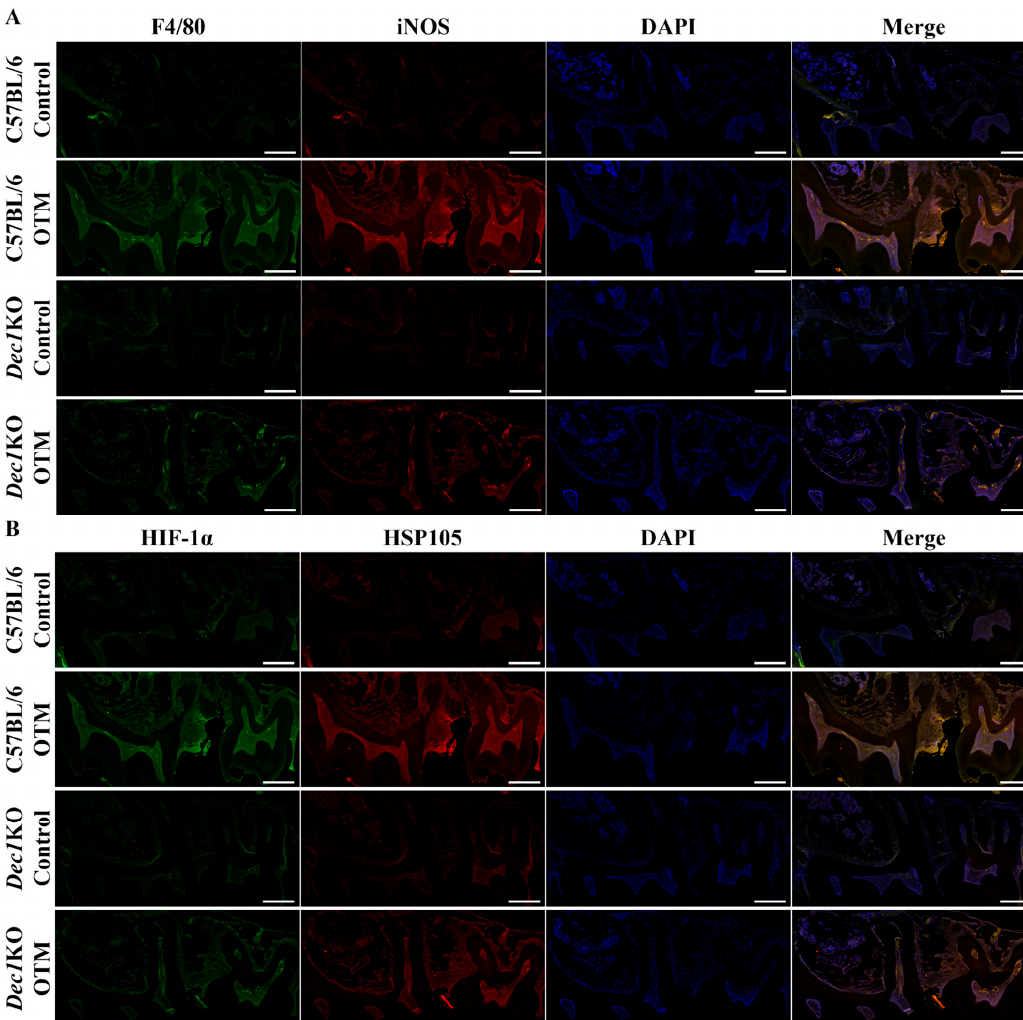
Figure 10. Effect of Dec1 on F4/80, iNOS, HIF-1 α and HSP105 in the OTM mouse model. ( A ) F4/80 and iNOS were reduced in the PDL fibroblasts of Dec1 KO OTM mice compared with WT OTM mice. ( B ) Deficiency of Dec1 decreased the expression of HIF-1 α and HSP105 in PDL fibroblasts of the OTM mouse model. All specimens were incubated with Zenon labeling complex and mounted with ProLong™ Gold Antifade Mount with DAPI. Scale bars = 100 μ m. All results are representative of at least three independent experiments.